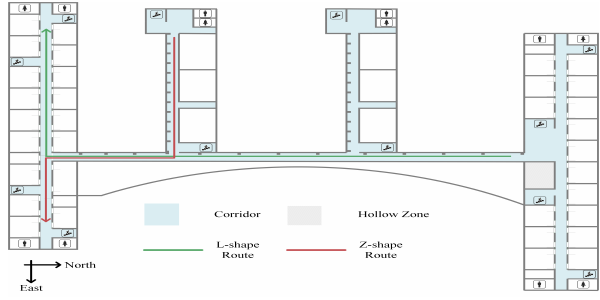
Figure 9. Experiment